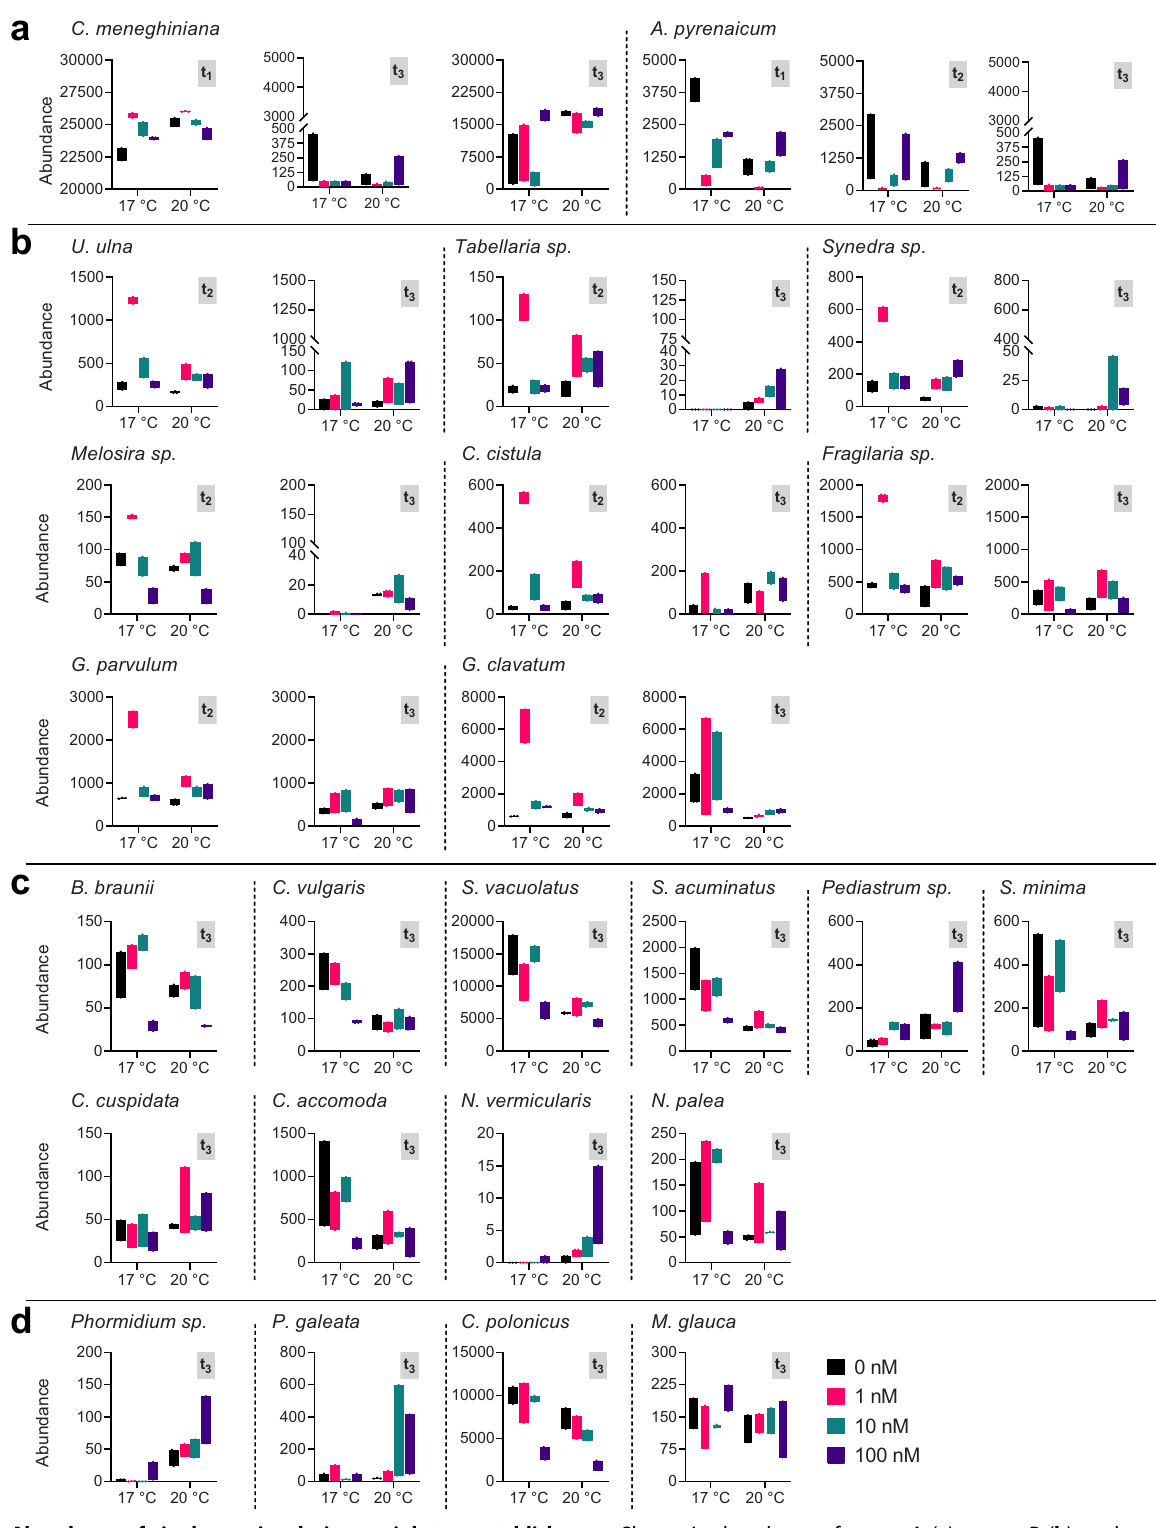
Fig. 5 Abundance of single species during periphyton establishment. Shown is abundance of group A ( a ), group B ( b ), and group C ( c ) eukaryotic species as well as group C prokaryotic species ( d ) measured at t 1 (A 4 days), t 2 (AB 18 days), and t 3 (ABC 30 days) and grown under different conditions. The conditions correspond to 4 levels of the herbicide terbuthylazine (0, 1, 10, and 100 nM) and 2 different temperatures (17 and 20 °C). Horizontal lines in the black boxes correspond to the average values and the lower and higher limits of the standard deviation ( n = 3). Results of the pairwise comparison (post hoc Tukey test) among all treatments for each species are shown in Supplementary Tables 13 –